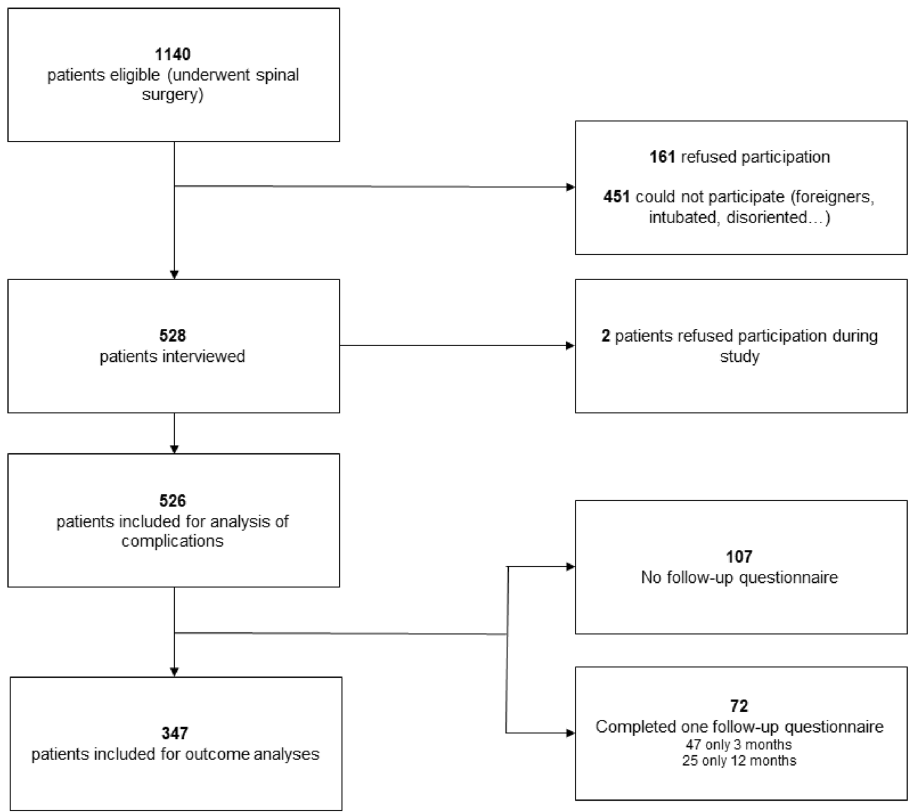
Figure 1. Flowchart showing patient inclusion and exclusion throughout the study.